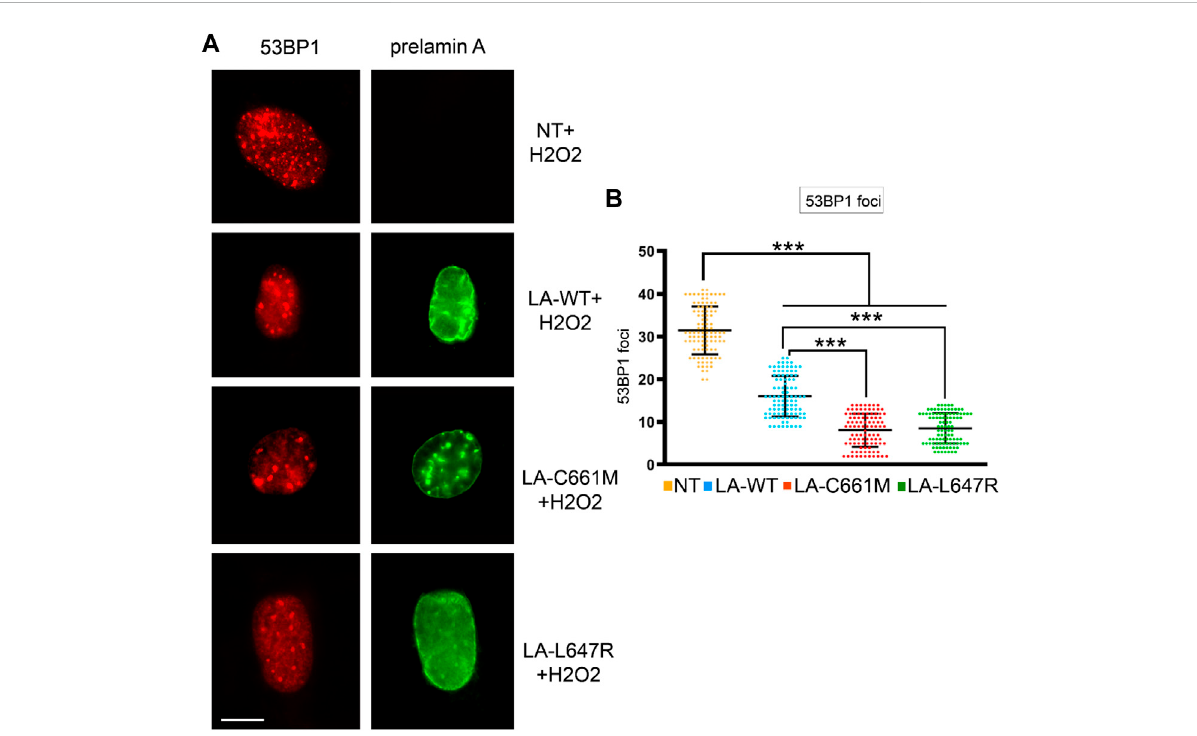
FIGURE 2 Stress-induced 53BP1 foci in human dermal fi broblasts overexpressing prelamin A mutants. (A) Immuno fl uorescence detection of 53BP1 (red) and FLAG-tagged prelamin A (green) in non-transfected fi broblasts (NT) or fi broblasts expressing wild-type prelamin A (LA-WT), non-farnesylated prelamin A (LA-C661M) or farnesylated and carboxymethylated prelamin A (LA-L647R) upon H2O2 administration. Bar, 10 μ m. (B) Dot plot showing the number of 53BP1 foci per nucleus as detected in (A). Experiments were conducted in triplicate, data analyzed were based on an average of 100 cells. Error bars, mean ± SD. Comparison between the groups was determined by using the one-way ANOVA test. Asterisks show statistical signi fi cance (***, p <